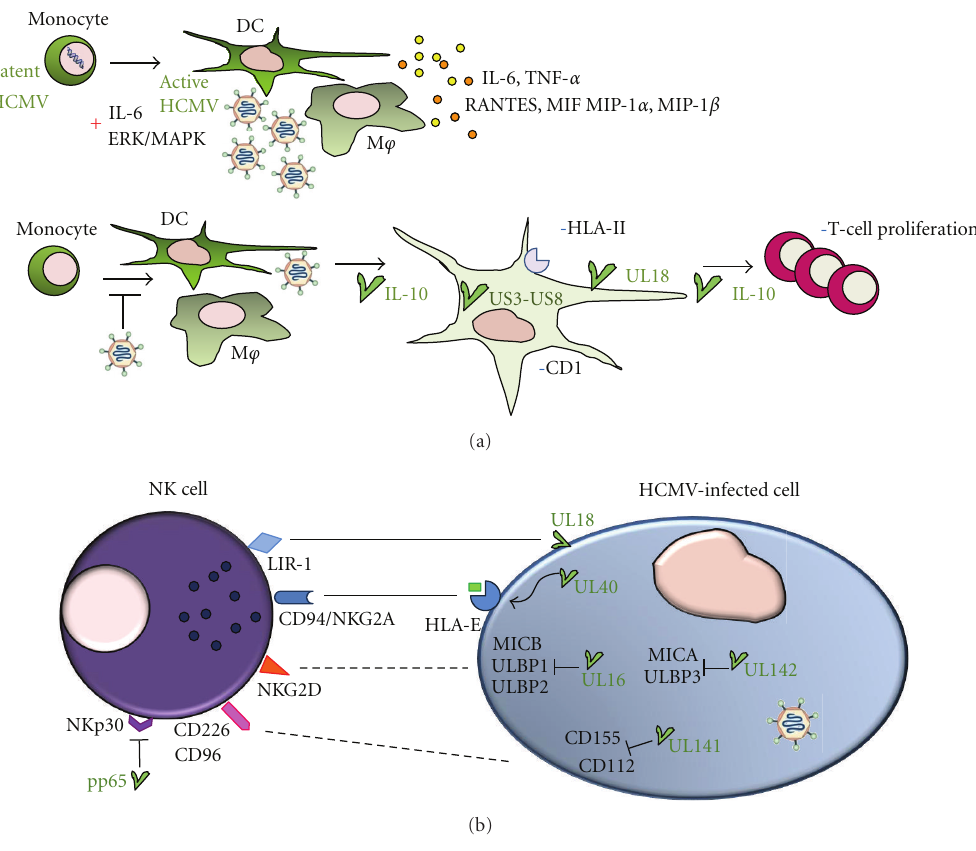
Figure 3: Cells of innate immunity, activation and virus counterattack. (a) HCMV reactivates from latency in infected monocytes by inflammation or cellular di ff erentiation, in which IL-6 and ERK/MAPK signaling are involved. Di ff erentiated macrophages (M ϕ ) and dendritic cells (DC) are permissive for viral replication and, once infected, release proinflammatory factors. HCMV hampers the ability of M ϕ and DC to properly di ff erentiate from monocytes and present antigens to T lymphocytes by downregulating surface expression of CD1 and HLA class II molecules. DC-induced T-cell proliferation also decreases through mechanisms that involve virally encoded IL- 10 and pUL18. IL-6, interleukin-6; TNF- α , tumor necrosis factor- α ; MIF, macrophage migration inhibitory factor; MIP-1 α , macrophage inflammatory protein-1 α ; MIP-1 β , macrophage inflammatory protein-1 β . +; upregulation or activation, − ; downmodulation or inhibition. (b) HCMV-encoded proteins modulate NK-cell recognition of infected cells. pUL40 binds to HLA-E and upregulates its surface expression, potentiating its interaction with the inhibitory receptor CD94/NKG2A. pUL18, an HLA-I viral homolog, binds to the inhibitory receptor LIR-1. Expression of the ligands of the activating receptor NKG2D is inhibited by pUL16 (which targets MICB, ULBP1, and ULBP2) and pUL142 (targeting MICA and ULBP3). pUL141 prevents the expression of CD112 and CD155, ligands of the activating receptors CD226 and CD96, whereas pp65 interferes with the signal transduction of the activating receptor NKp30. Solid lines: possible interactions resulting in NK-cell inhibition. Dotted lines: impairment of interactions between activating receptors and their